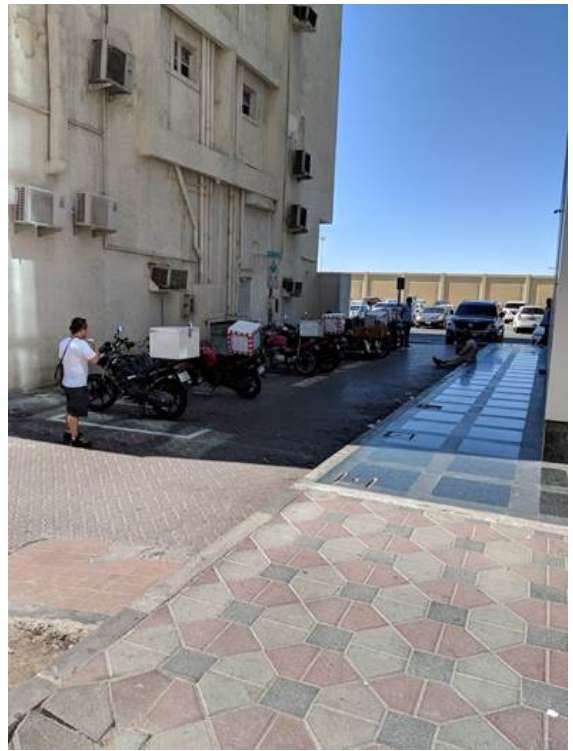
Delivery motorcycles and bicycles parked in the space. Most residents of the building and users of the space work in lower-paying jobs such as food delivery or as grocery store attendants (Source: